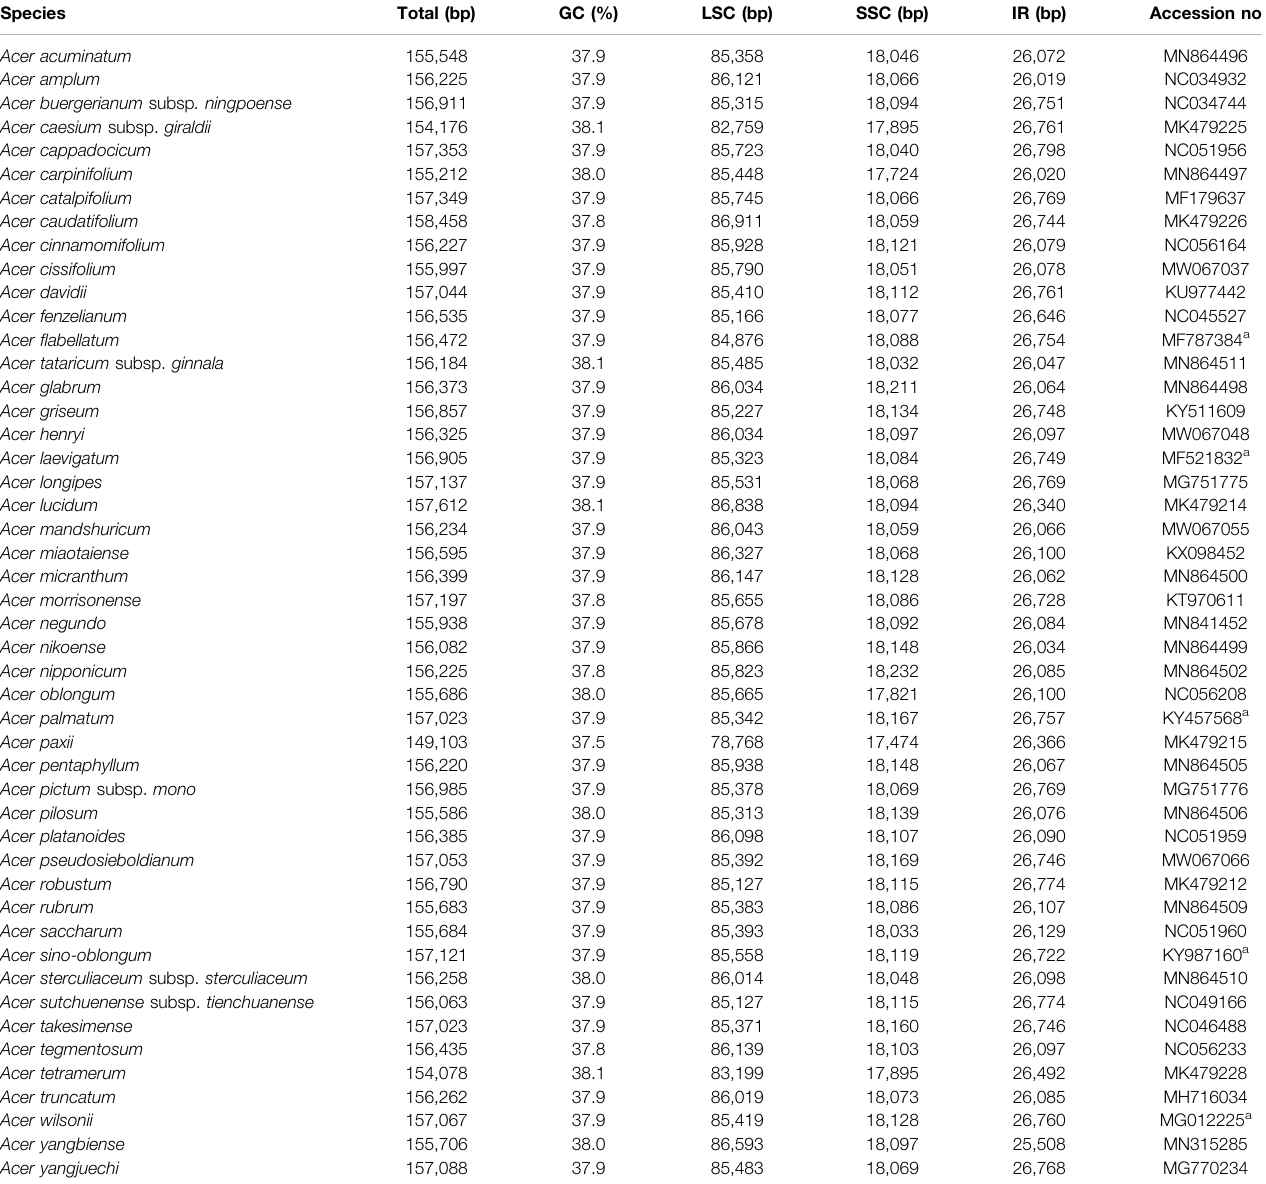
TABLE 1 | General features of the Acer chloroplast genomes compared in this study. Species Total (bp) GC (%) LSC